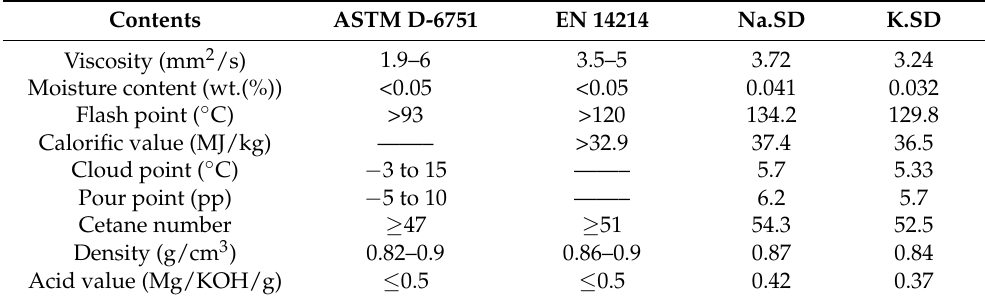
Table 2. The physical properties of the biodiesel products using Na.SD and K.SD